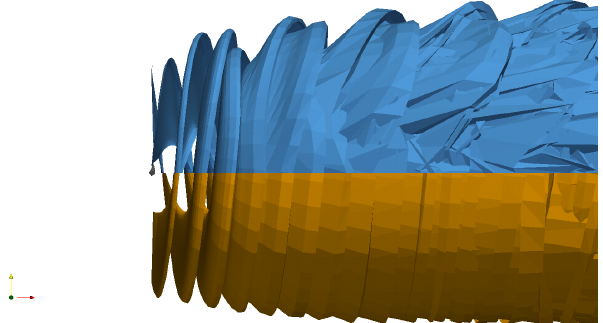
Figure 28. Wake for real (top, blue) and pseudo (bottom, orange) sway motion at f = 4Hz.